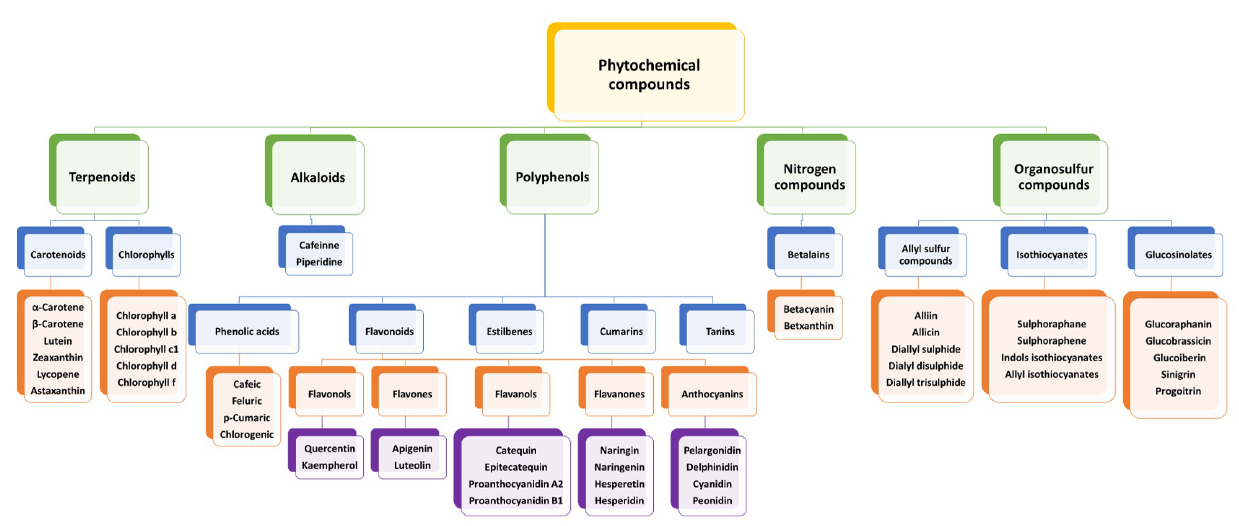
Figure 1. Classification of the main phytochemical compounds in fruit and vegetables (F&V)